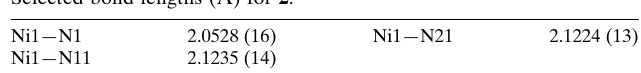
Table 2 Selected bond lengths (A˚ ) for 2 .